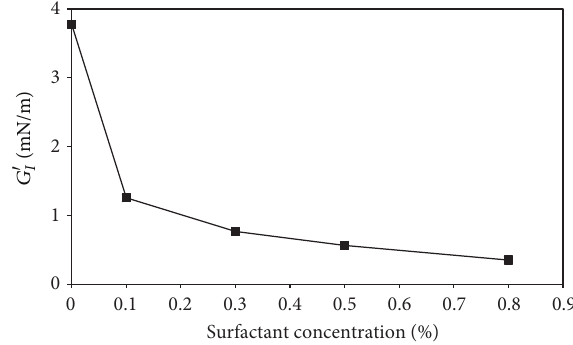
Figure 5: Effect of surfactant concentration on interfacial storage modulus of copolymer in deionized water at 25 ∘ C.